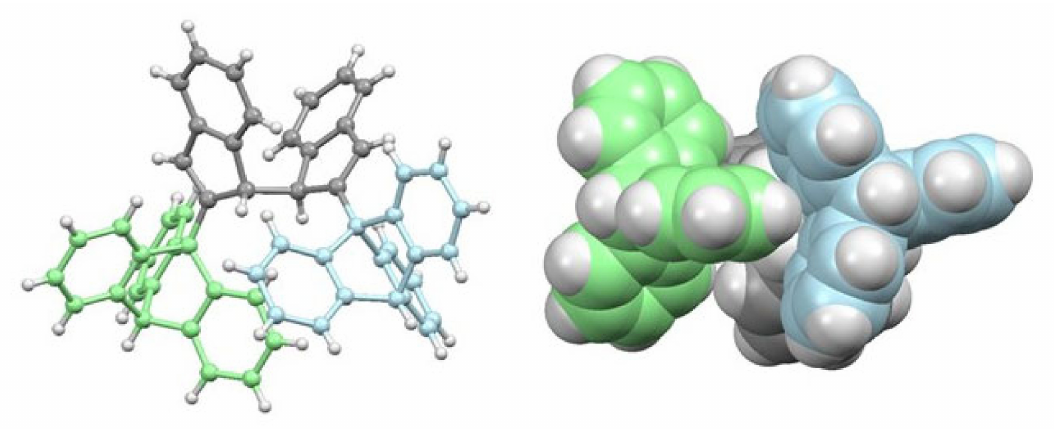
Figure 25. Molecular structure of rac -2,2 (cid:48) -di(9-triptycyl)-1,1 (cid:48) -biindenyl, 51 , and a space-fill view showing the gear meshing of the triptycyl groups [31].